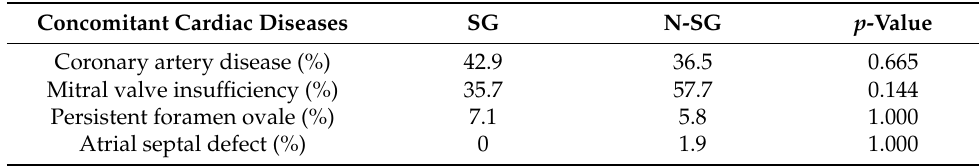
Table 2. Concomitant cardiac diseases.